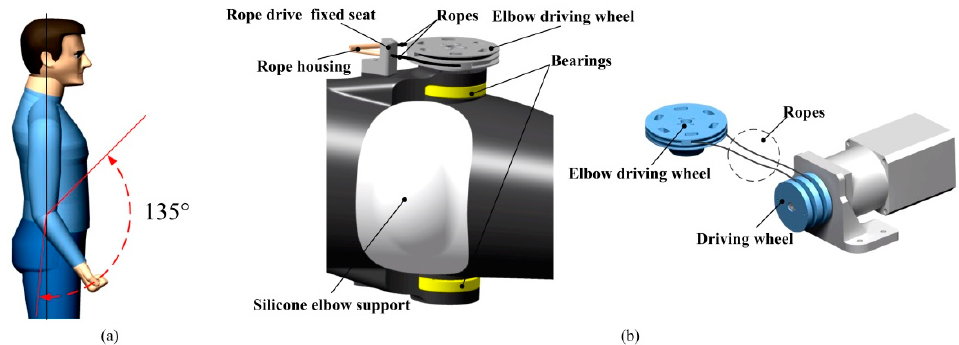
Figure 3. Elbow joint structure diagram. ( a ) Elbow joint freedom of motion; ( b ) 3D model of elbow joint.